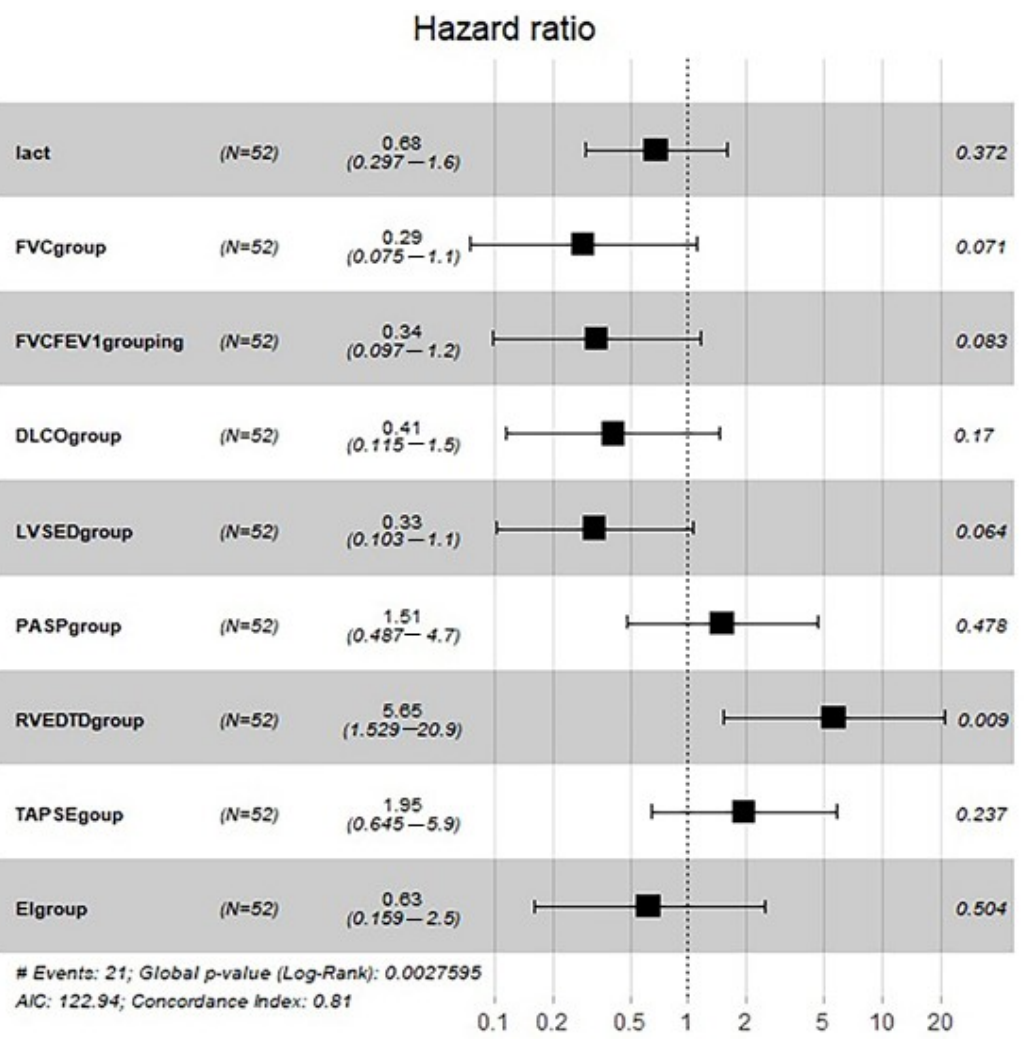
Figure 6. Cox univariate regression analyses for all-cause mortality among COPD patients. COPD: chronic obstructive pulmonary diseases; FEV1: forced expiratory volume in 1 s; FVC: forced vital capacity; DLco: diffusing capacity for carbon monoxide; RVEDTD: right ventricular end-diastolic transverse dimension; PASP: pulmonary arterial systolic pressure; ENDSEI: end-systolic stage eccentricity index; TAPSE: tricuspid annular plane systolic excursion.